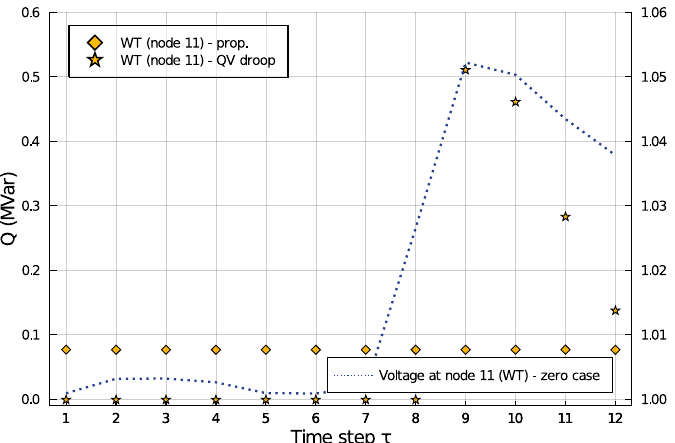
Figure 9. Reactive power support from the DERs for each time step τ during the 8th hour of the chosen day and the corresponding voltage at one of the nodes with